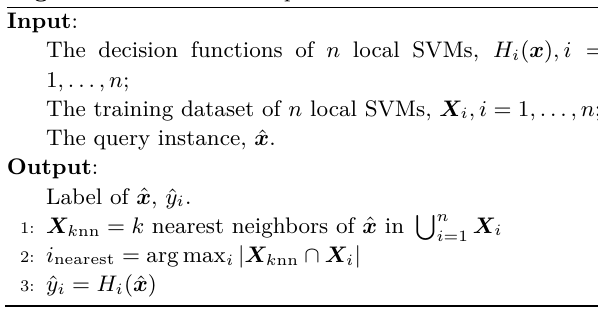
Algorithm 1 Prediction procedure of local SVMs